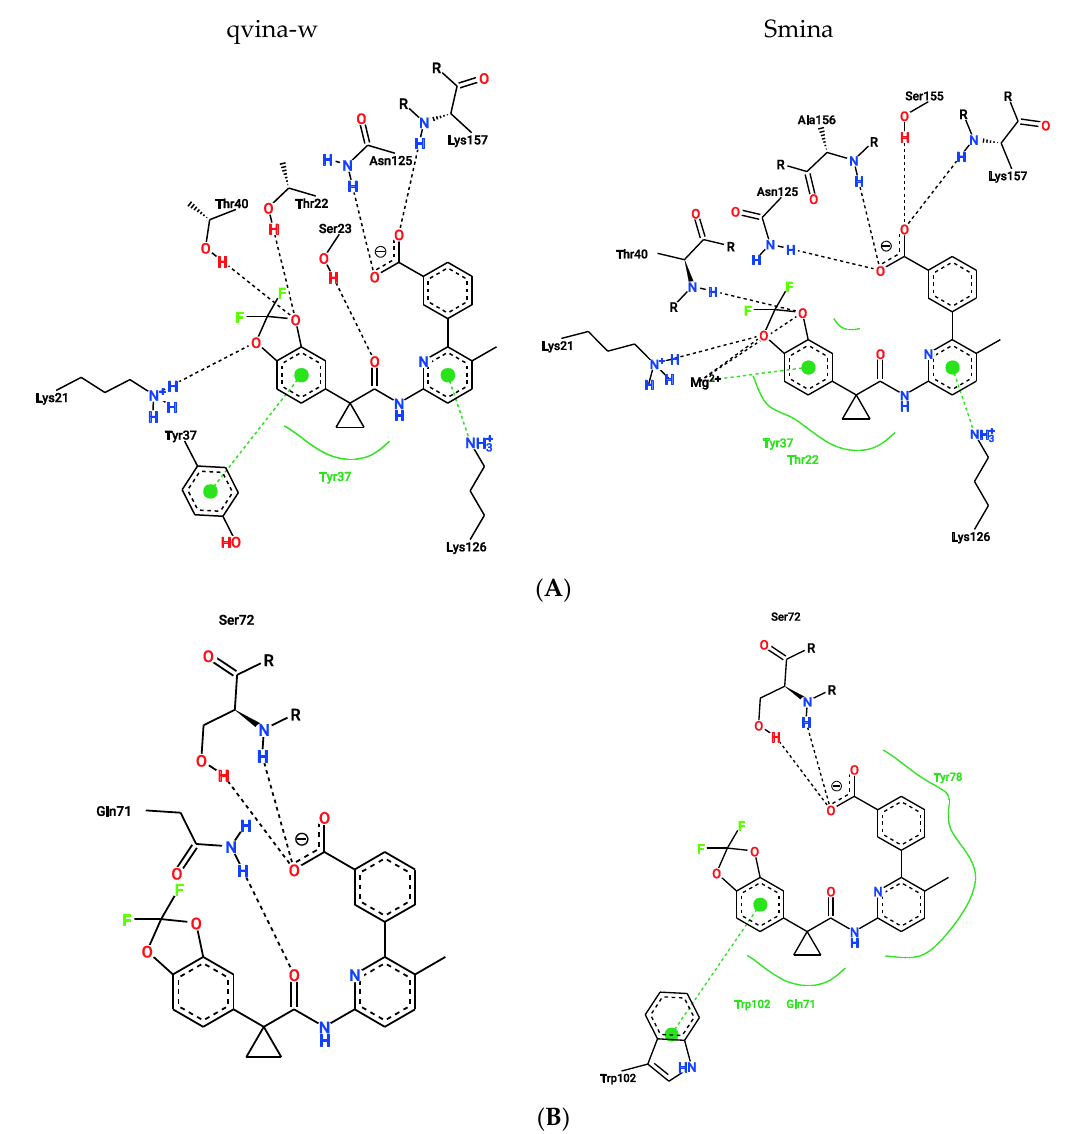
Figure 6. Two-dimensional representation of the docking poses of Lumacaftor to RAB7A and predicted interactions between them. Black dashed lines represent hydrogen bonds, green spline sections show hydrophobic interactions and green dashed lines represent π - π stacking or π − cation interactions. ( A ) Docking poses calculated by qvina-w and Smina for binding pocket A. ( B ) Docking poses calculated by qvina-w and Smina for binding pocket B.